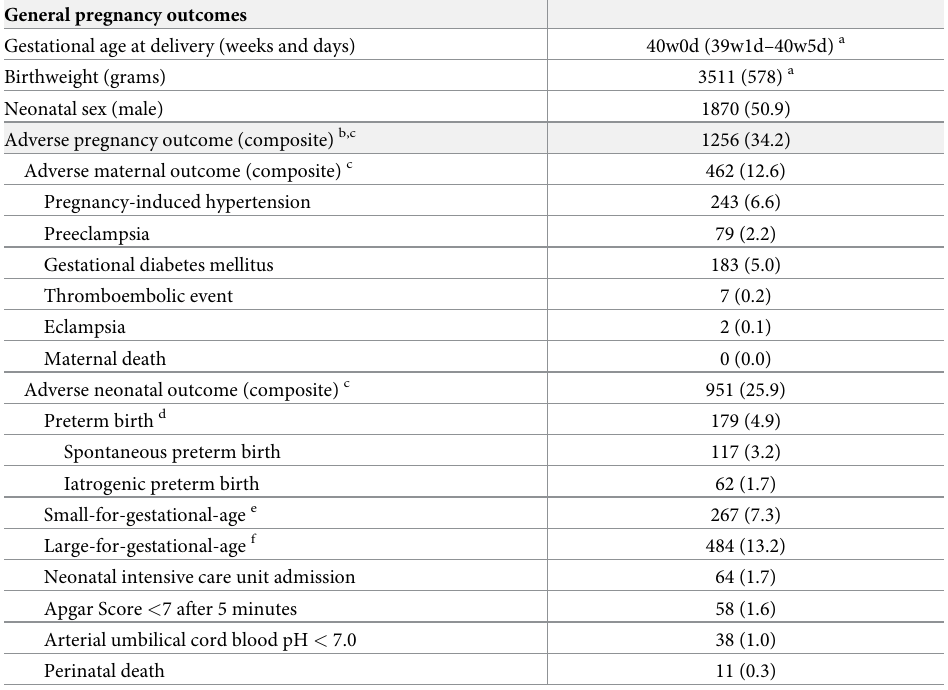
Table 2. Pregnancy outcomes in the study population (n = 3671). General pregnancy